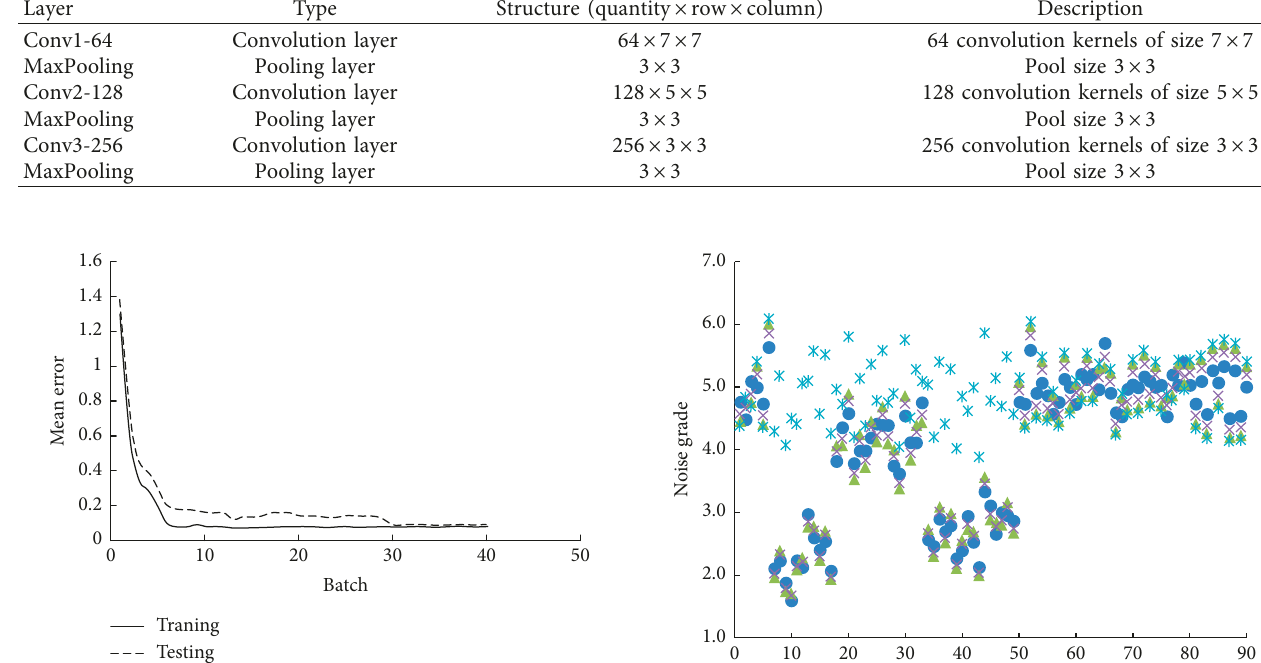
Figure 13: Training process of CNN model.